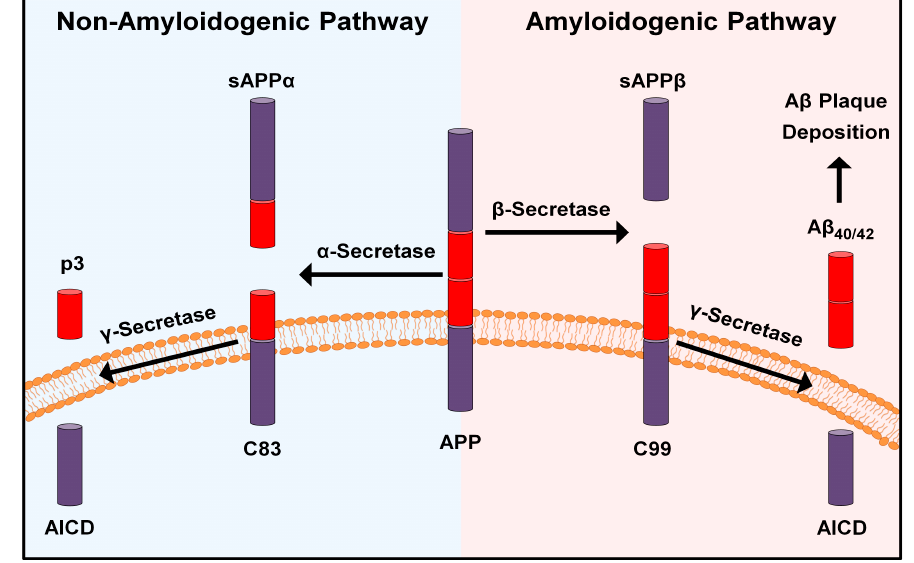
Figure 1. Illustration of the non- and amyloidogenic pathways.